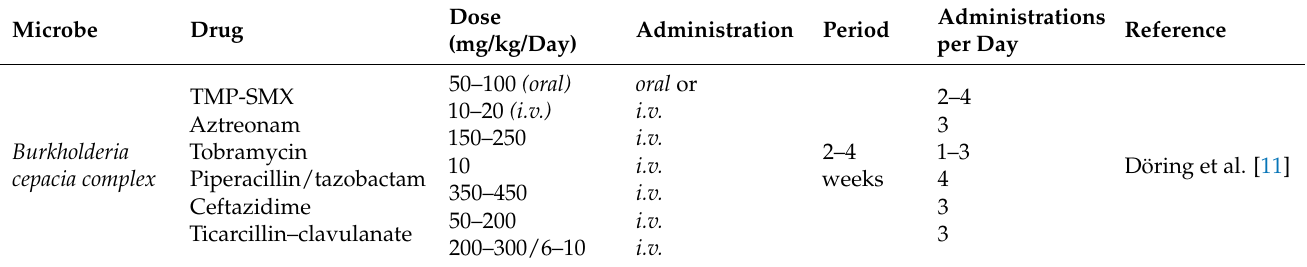
Table 4. Recommended antibiotics for Burkholderia cepacia complex infection in CF